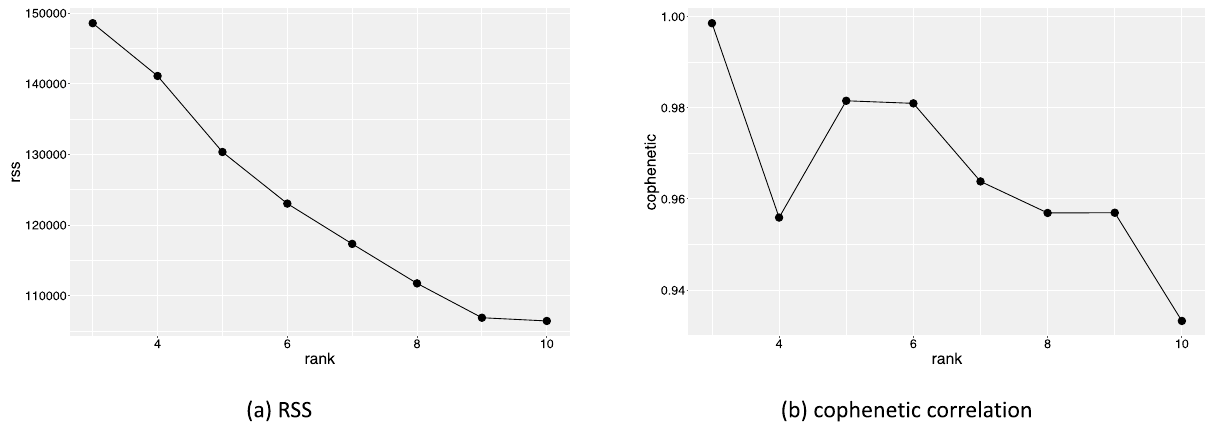
Figure 4. Rank dependence of ( a ) residual sum of squares(RSS) and ( b ) cophenetic